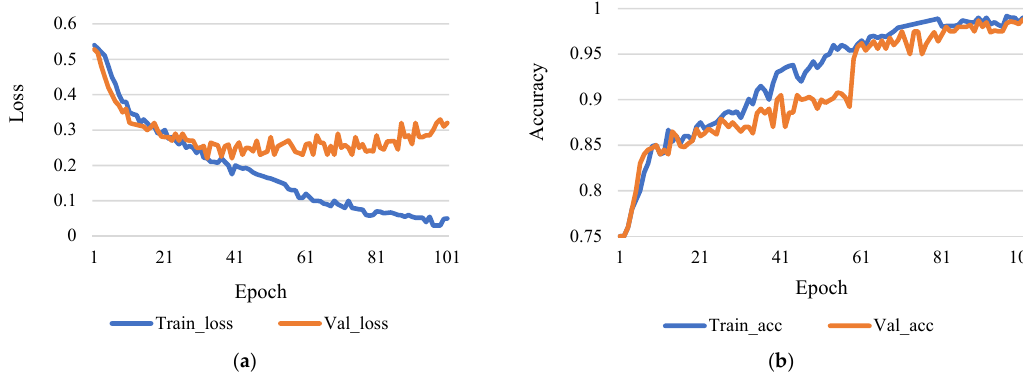
Figure 5. ( a ) Training loss vs validation loss (rate of learning 0.0001 and epoch 100). ( b ) Training accuracy vs validation accuracy (rate of learning 0.0001 and epoch 100).